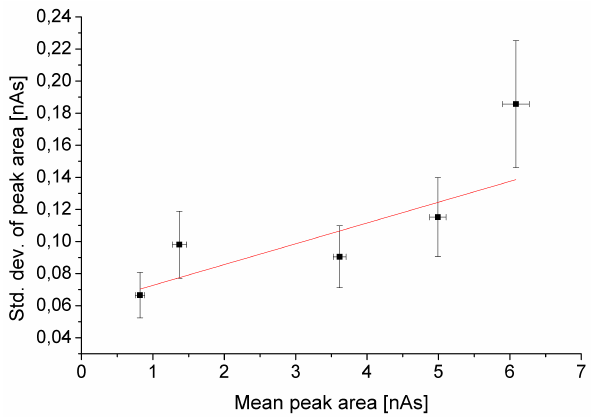
Fig. 8. Standard deviations of the peak area versus the mean peak area for five peaks of different sizes, based on measurements of standard A; the error bars represent the uncertainties of the standard deviation (see text). A linear fit (red line) is applied to the data.